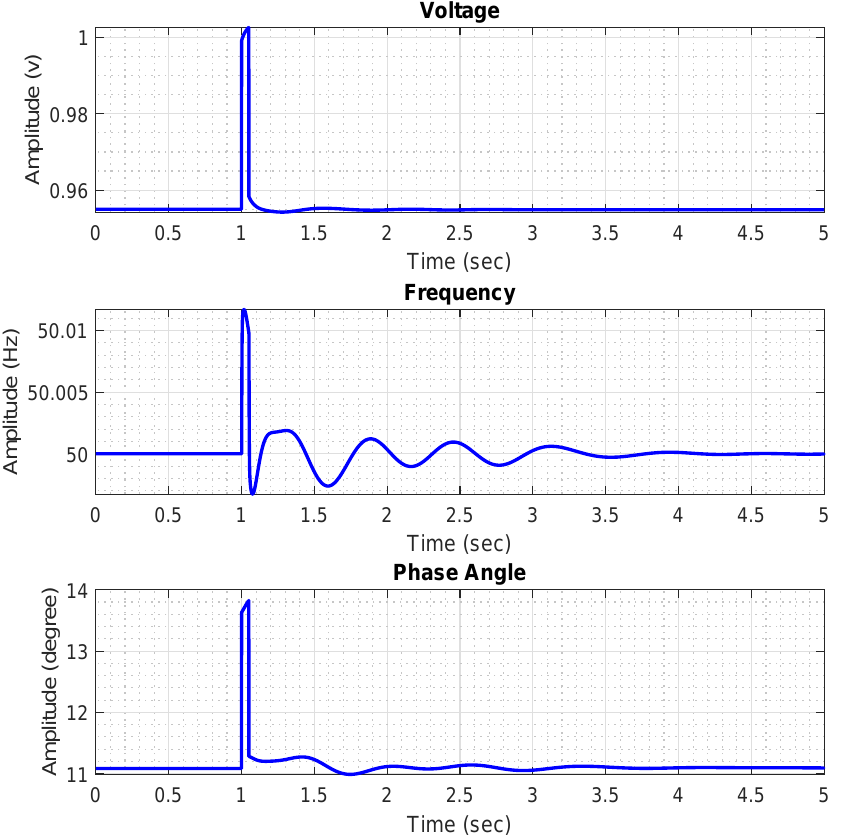
Figure 2. The collected voltage, frequency, and phase angle measurements following an LL fault on bus #1 at t = 1 second of the